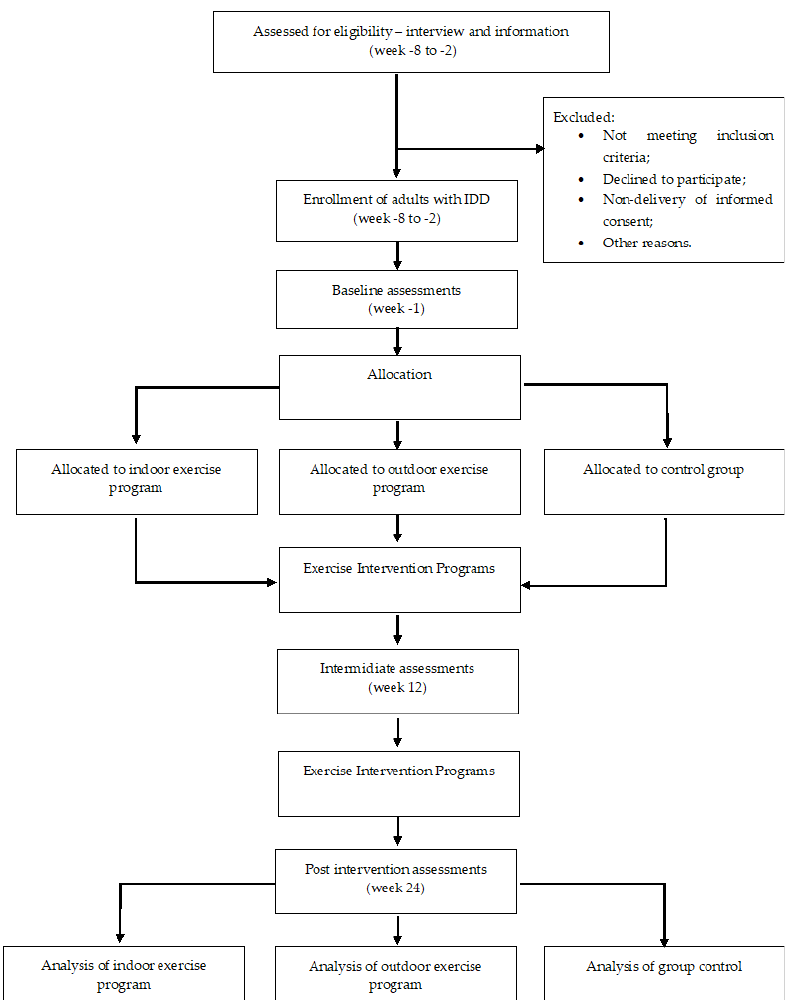
Figure 1. Timeline for the study design.